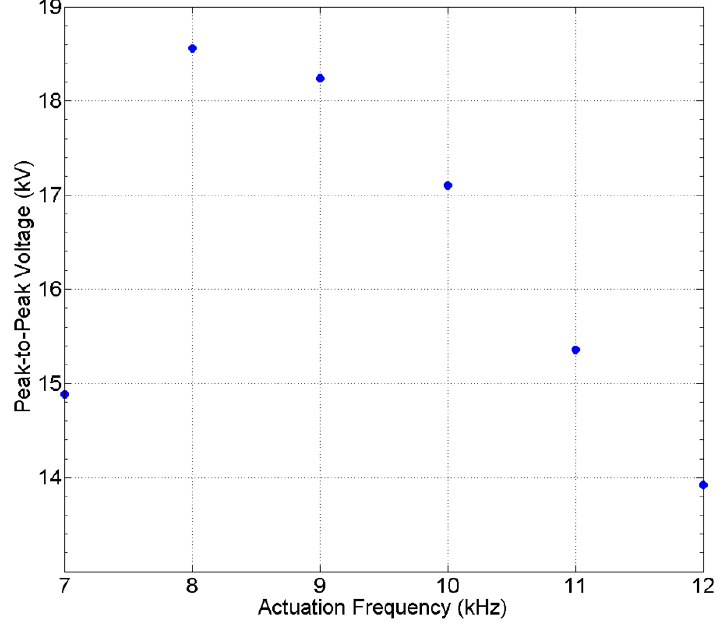
Figure 4. Peak-to-peak voltage output at different actuation frequencies.